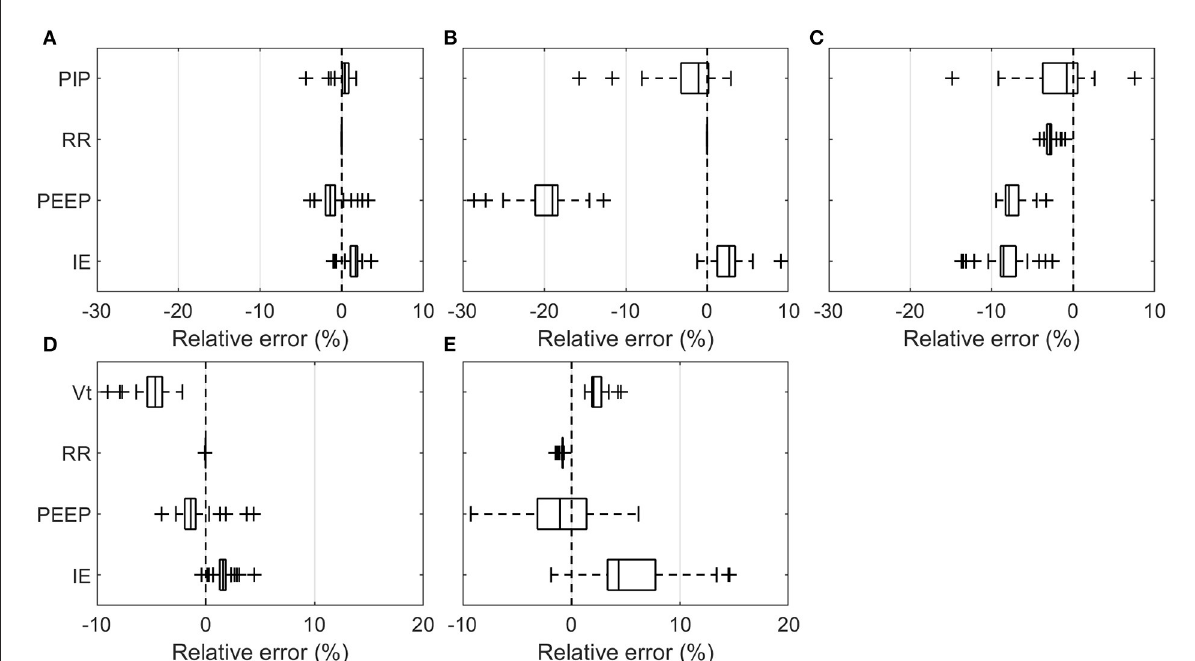
FIGURE3 Boxplot representation of the relative error over all means of the individual measurement sets listed in Table 3. PIP, V t , RR, PEEP, and I:E are shown at varying RR, PEEP, I:E, C rs , and R aw for the pressure- and volume-controlled ventilators. (A) Hamilton T1 (PCV + ), (B) HEV, (C) GirVent,